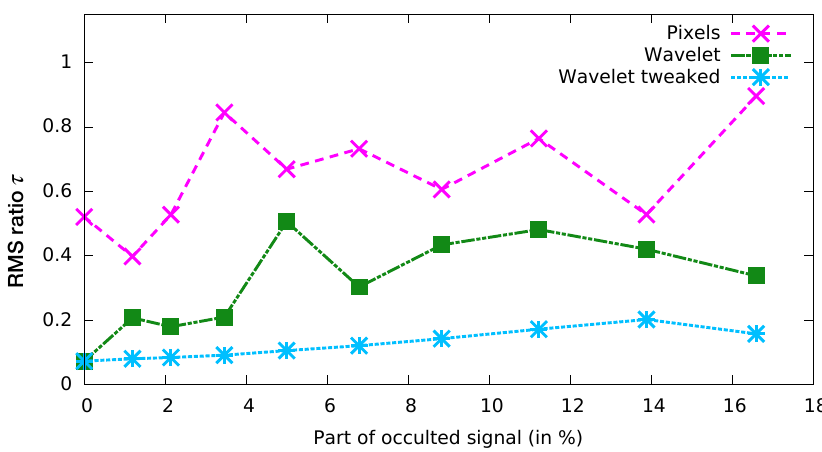
Figure 7. Ratio τ between the analysed state RMSE and the background RMSE for observations distorted by a strong spatially correlated additive noise, as a function of the percentage of missing observation points.